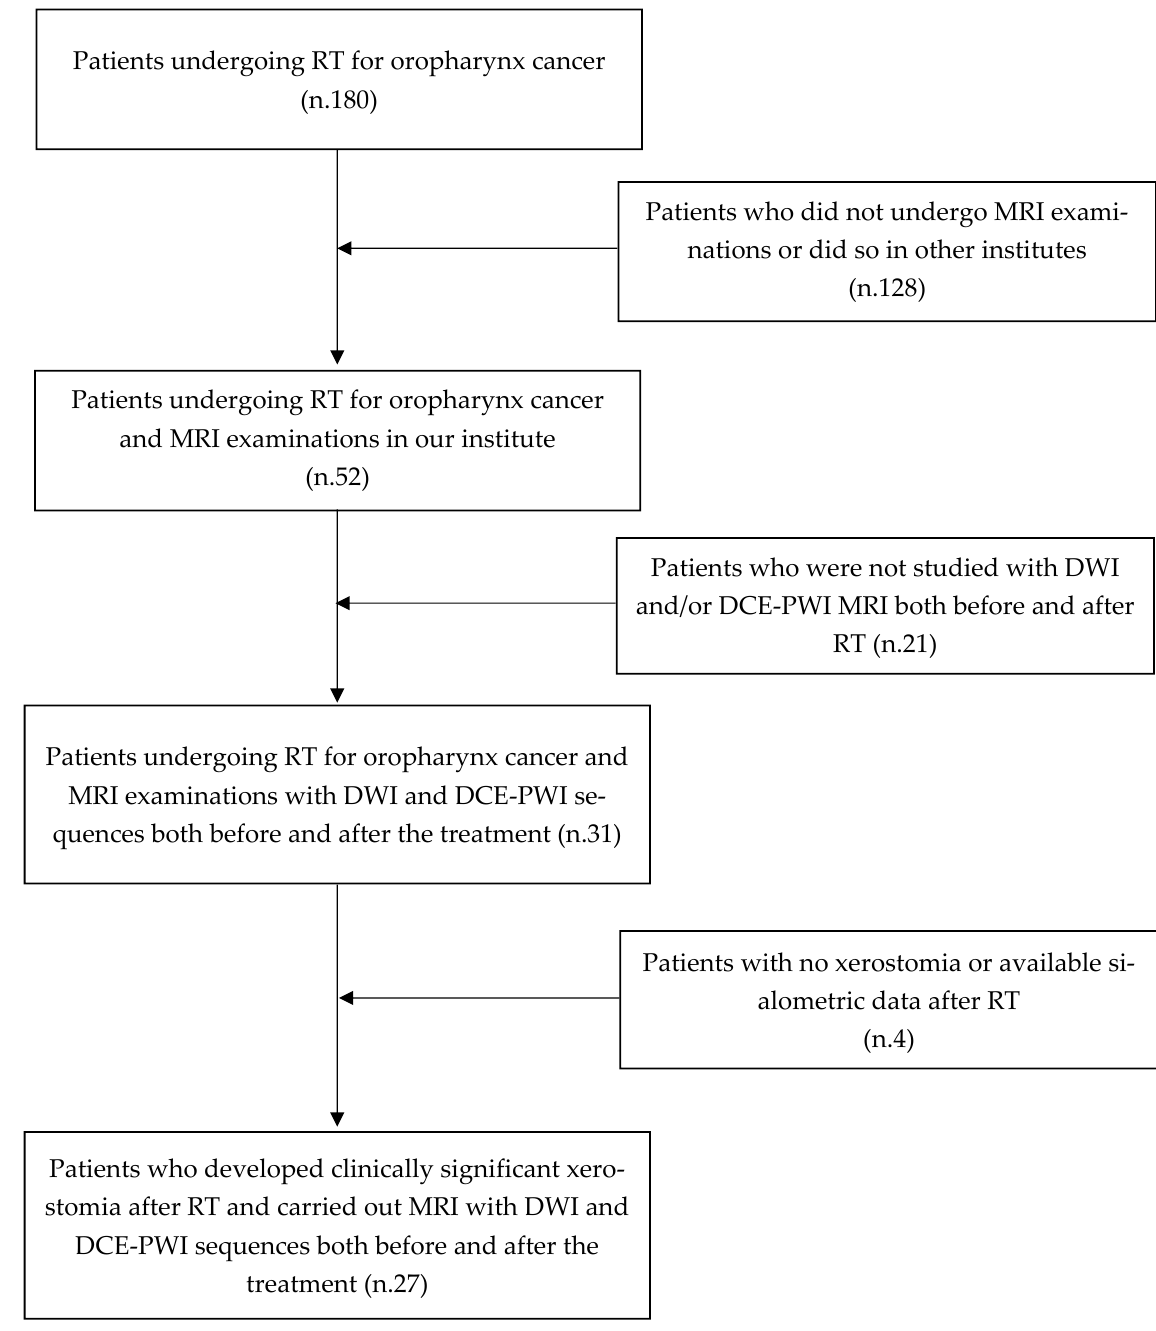
Figure 1. Patient inclusion/exclusion flowchart. RT = radiotherapy, MRI = magnetic resonance imaging, DWI = diffusion-weighted imaging, DCE-PWI = dynamic contrast-enhanced, perfusion-weighted imaging.